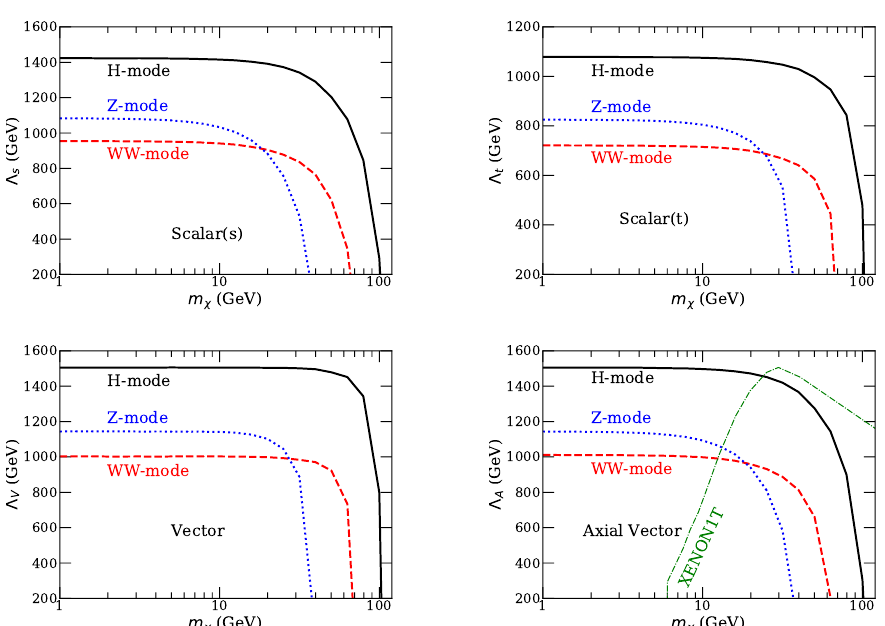
Figure 16 . Expected CEPC 95% CL lower bound on (cid:3) with four di(cid:11)erent DM e(cid:11)ective operators: the s-channel scalar interaction (upper left), the t-channel scalar interaction (upper right), the vector interaction (lower left), the axial-vector interaction (lower right). The SD limit from Xenon1T [51] is drawn for the axial-vector operator case, under the assumption that the e(cid:11)ective operator coupling is